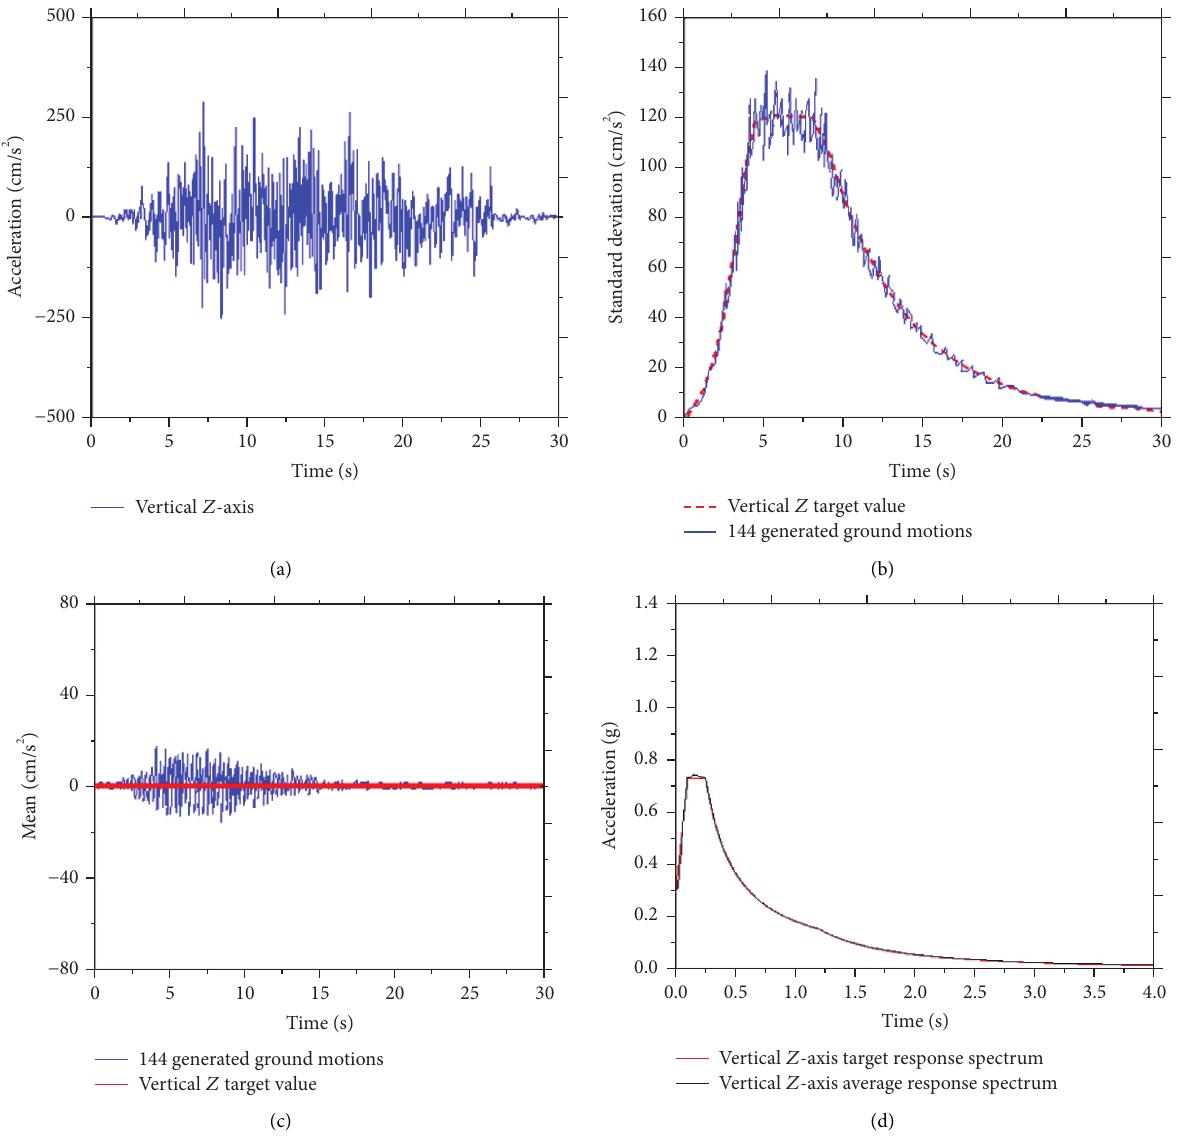
Figure 8: Comparison of the horizontal Z component of the sample with the target value. (a) Representative time history, (b) mean, (c) standard deviation, and (d) average response